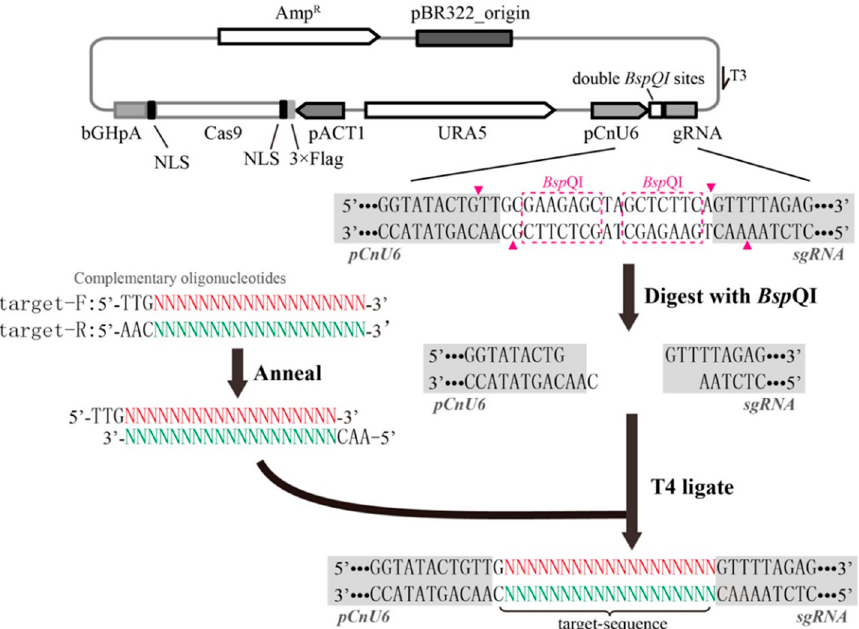
Figure 1. Schematic illustration of the method used to rapidly introduce a target sequence into the gRNA expression cassette in the new CRISPR-Cas9 vector. Three cassettes, including a selection marker, Cas9 nuclease, and a single gRNA with two reverse BspQI restriction sites, were included in the plasmid. After digestion using BspQI, a pair of annealed oligonucleotides containing 5 ′ compatible TTG and AAC overhangs were cloned scarlessly into the vector right before the sgRNA scaffold. The pink dotted lines show the sites for BspQI recognition, and BspQI digestion occurs at the sites of the pink triangles.